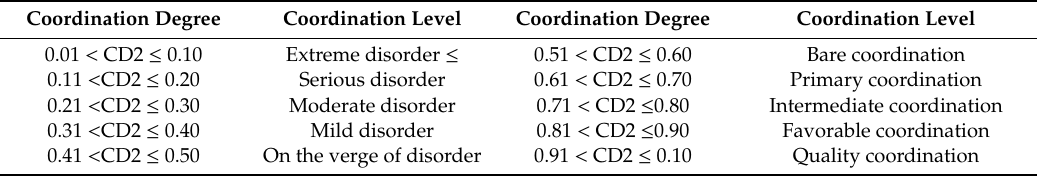
Table 2. Classification of the coupling coordinated